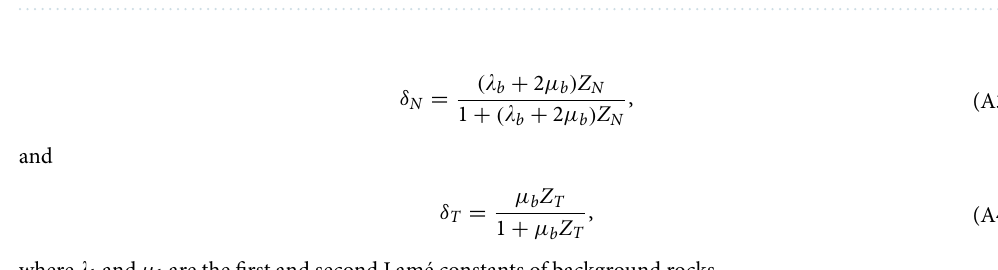
Figure 12. Comparison of histograms between original and inverted normal and shear weaknesses in time, frequency, and joint time–frequency domains, where (a) shows the results of normal weakness, and (b) shows the results of shear